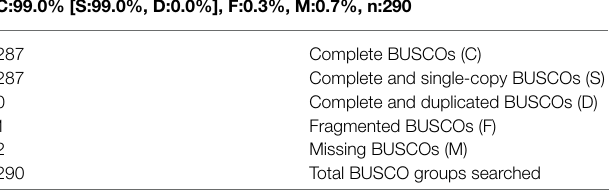
TABLE 2 | Summary of BUSCO analysis of genes selected from the A. alternata (Y784-BC03)